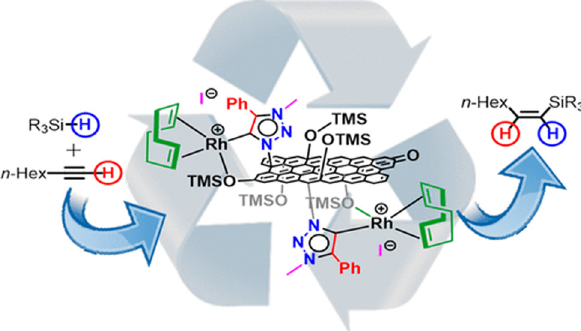
Figure 4: Graphene modi fi ed with rhodium - based N - heterocyclic carbenes for alkyne hydrosilylation. Reprinted ( adapted ) with permission from American Chemical Society. Ref. [ 138 ] ACS Applied Nano Materials 2020;3 ( 2 ) :1640 – 55.